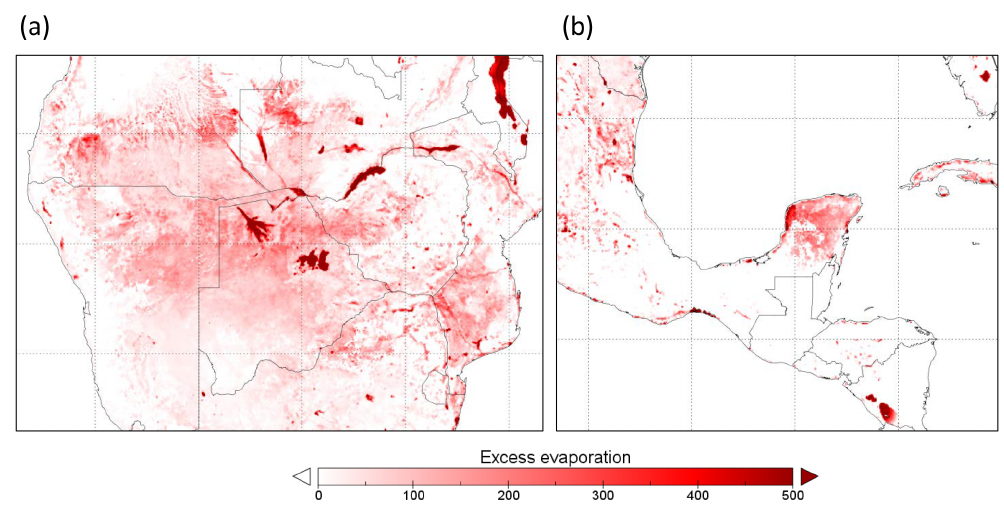
Figure 12. Mean difference between total evaporation and precipitation for 2001–2014 for (a) Botswana, (b) the Yucatán peninsula and surrounding